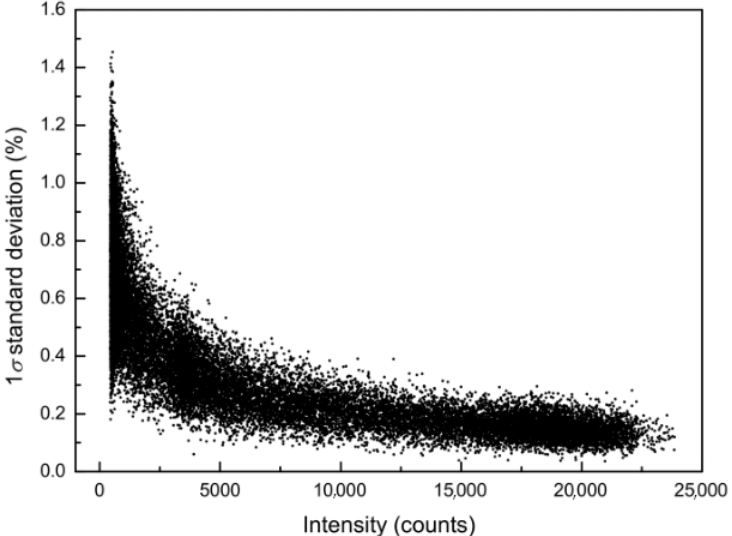
Figure 12. Relative detector noise as a function of intensity (counts) of the CCD detector given as 1 σ standard deviation (%).